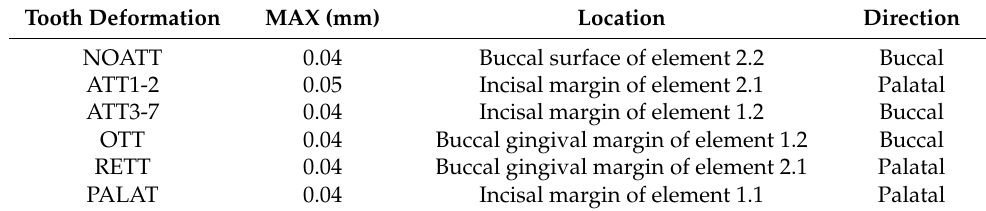
Table 3. Maximum tooth deformation and locations.